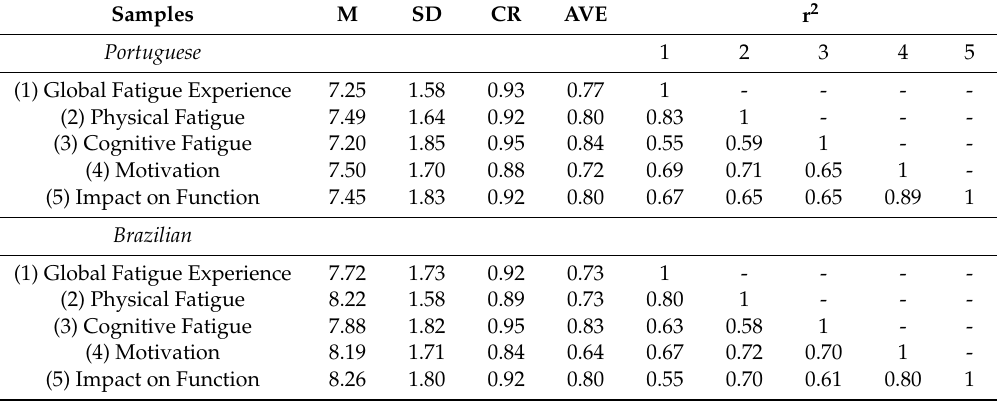
Table 3. Descriptive statistics, composite reliability coe ffi cients, AVE scores and squared